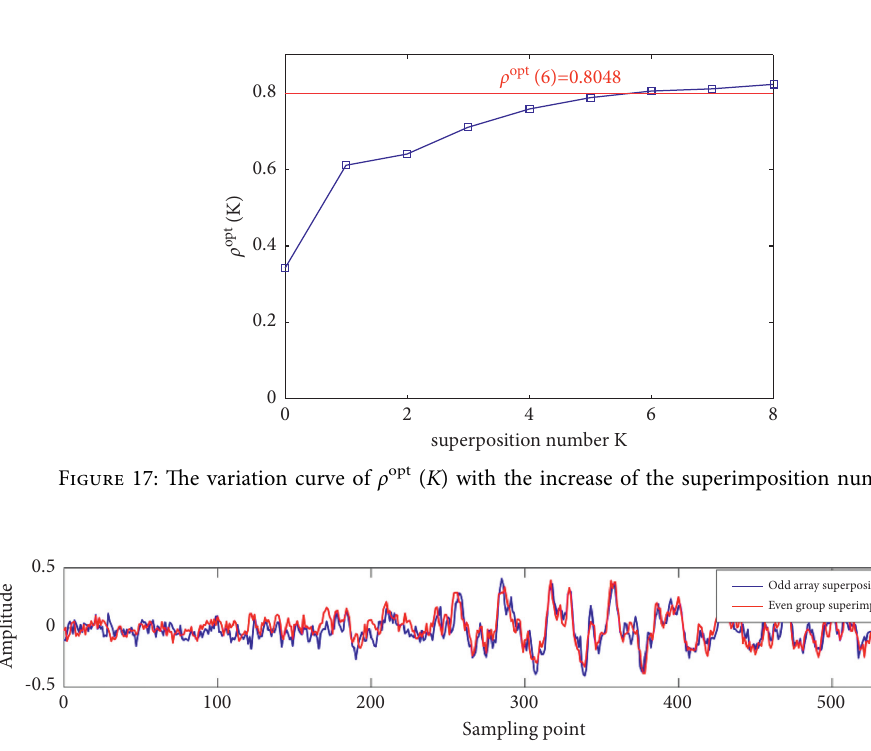
Figure 18: Odd group and even group superposition signals after 6-time superposition.